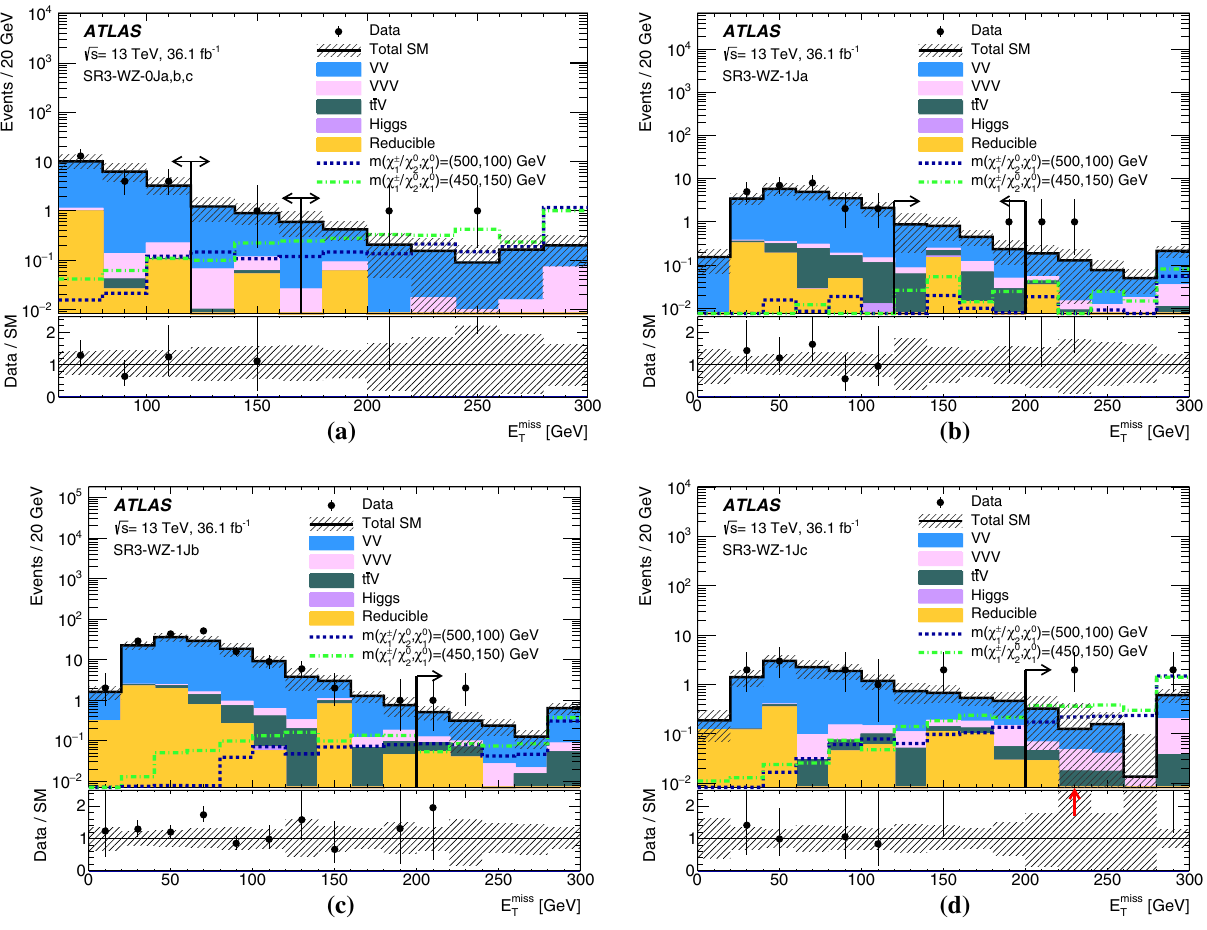
Fig. 7 Distributions of E miss all systematic and statistical contributions. Simulated signal models for for data and the estimated SM back- T charginos/neutralinos production are overlayed for comparison. The grounds in the 3 (cid:4) channel for a SR3-WZ-0Ja,b,c, b SR3-WZ-1Ja, c final bin in each histogram also contains the events in the overflow bin. SR3-WZ-1Jb and d SR3-WZ-1Jc. The normalization factors extracted The vertical red arrows indicate bins where the ratio of data to SM back- from the corresponding CRs are used to rescale the 0-jet and ≥ 1-jet W Z background components. The “reducible” category corresponds ground, minus the uncertainty on this quantity, is larger than the y -axis maximum to the data-driven fake-factor estimate. The uncertainty bands include